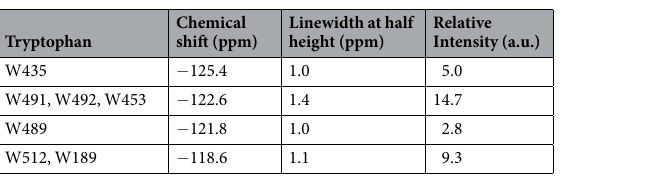
Table 2. 19 F solid-state NMR chemical shifts of Trp residues of the 19 F-LLO bound to POPC/Chol